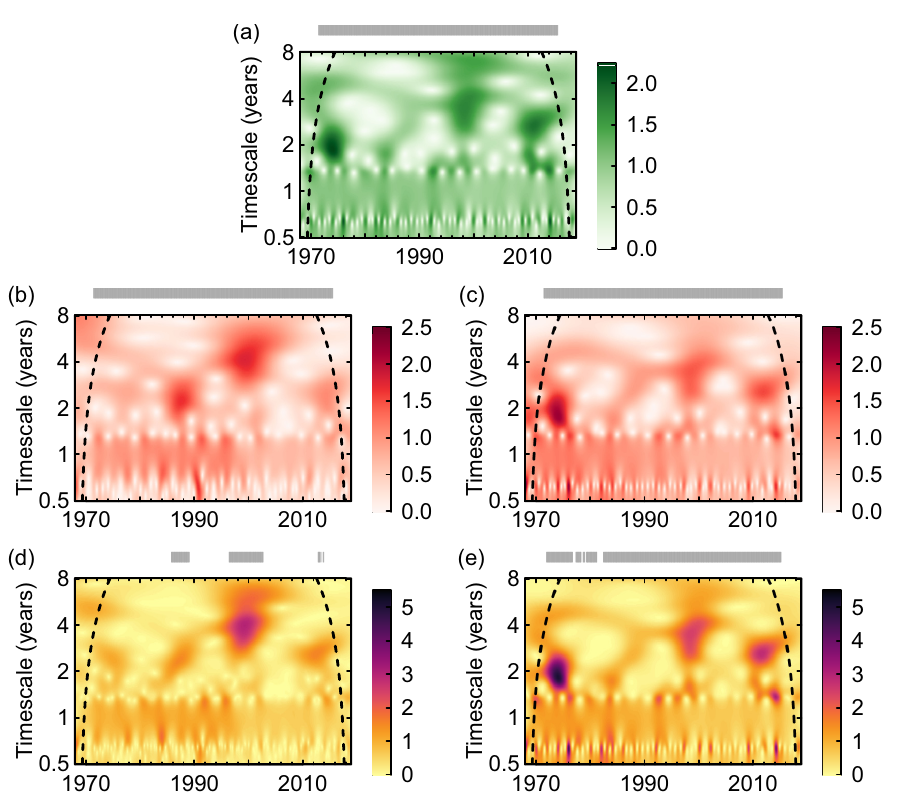
Fig 2. (Cross-)WMFs. WMFs for (a) temperature, and ln-transformed dengue cases from the (b) passive surveillance data and (c) model output. Cross-WMFs between (d) temperature and ln-transformed dengue cases (data) and (e) temperature and ln-transformed dengue model output. Model output assumes a mean cross-protection of 1 year (see S13 Fig in S1 Appendix for results using other mean cross-protections). The same temperature time series are used for both (d, e). Grey bars above panels indicate the times for which phases (in a–c) and phase difference angles (in d, e) are highly consistent across provinces and statistically significant (see section “Material and methods”). In (a–c), higher values in the mean fields indicate timescales and points in time where the phases are more consistent across provinces, and where the amplitudes of oscillations are more correlated. In (d, e), higher values correspond to timescales and points in time where the agreement between dengue and temperature is itself more consistent across provinces. S14 Fig in S1 Appendix shows which multiannual timescales dominate the (C) WMFs for each panel in this figure. Edge effects in the WTs may influence results before and after the dashed lines (see section “Materials and methods”). The underlying data are in S1 Data at https://github.com/UF-IDD/synchrony_dengue_figures. WMF, wavelet mean field; WT, wavelet